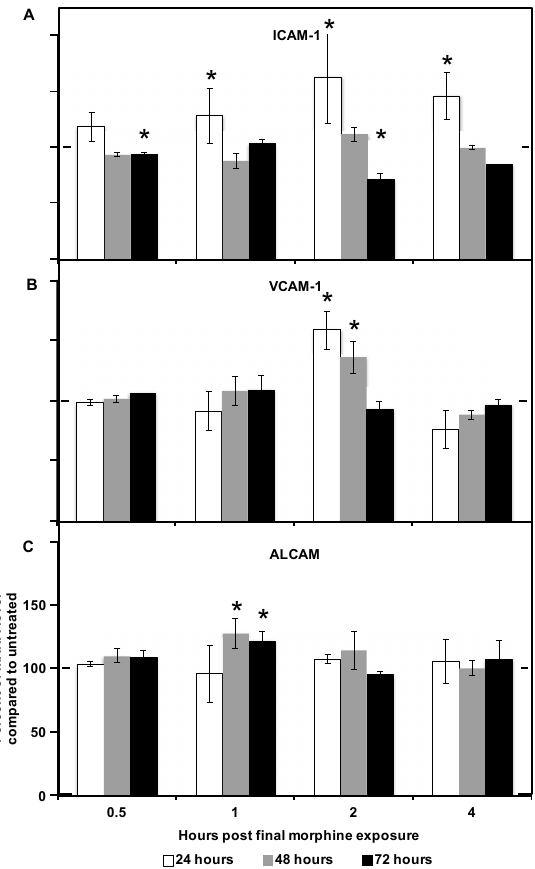
Figure 2. Prolonged morphine exposure induced changes in mRNA levels of CAMs (cellular adhesion molecules) in hCMEC/D3 cells. hCMEC/D3 cells were treated with morphine as previously described. Intercellular adhesion molecule-1 (ICAM-1; A ), vascular cell adhesion molecule-1 (VCAM-1; B ), and activated leukocyte cell adhesion molecule (ALCAM; C ) mRNA levels were measured by RT-PCR at the indicated time points with total exposure times of 24, 48, or 72 h. All bars represent average percent of relative mRNA level compared with the untreated condition, with the values obtained from untreated monolayers normalized to 100%. Averages were derived from two independent experiments performed in duplicate. Relative mRNA was calculated based on the geometric mean of β -actin and glyceraldehyde 3-phosphate dehydrogenase (GAPDH). Levels of β -actin and GAPDH did not change as a result of any treatments. * p < 0.05 as determined by Student’s t -test. The dashed line is set to 100% for ease of comparison.